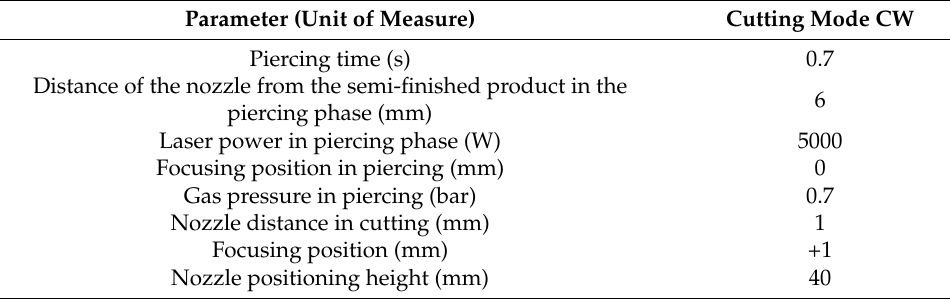
Table 2. Working parameters of ByAutonom 4020